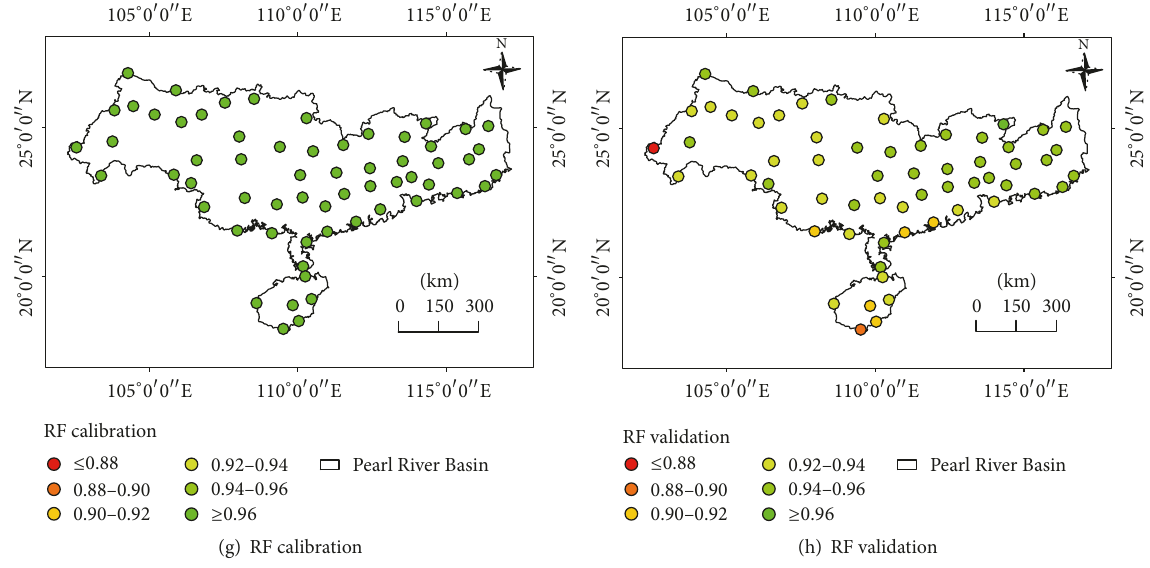
Figure 9: The spatial distribution of Nash for different